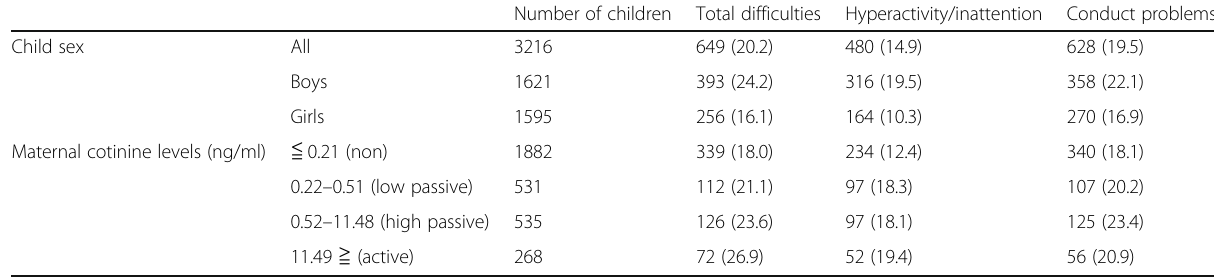
Table 2 Number and percentage of children in borderline and clinical range scores of behavioral problems and ADHD symptoms by child sex and maternal cotinine levels at the third trimester ( n = 3202) Number of children Total difficulties Hyperactivity/inattention Conduct